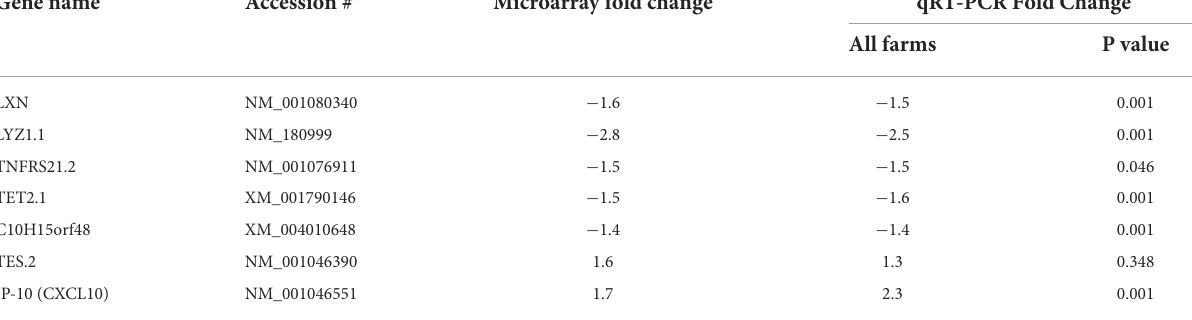
TABLE 6 Fold change comparison of the observed array gene expression and the qPCR validation of expression in a wider cohort of sheep (samples sourced from 4 commercially maintained